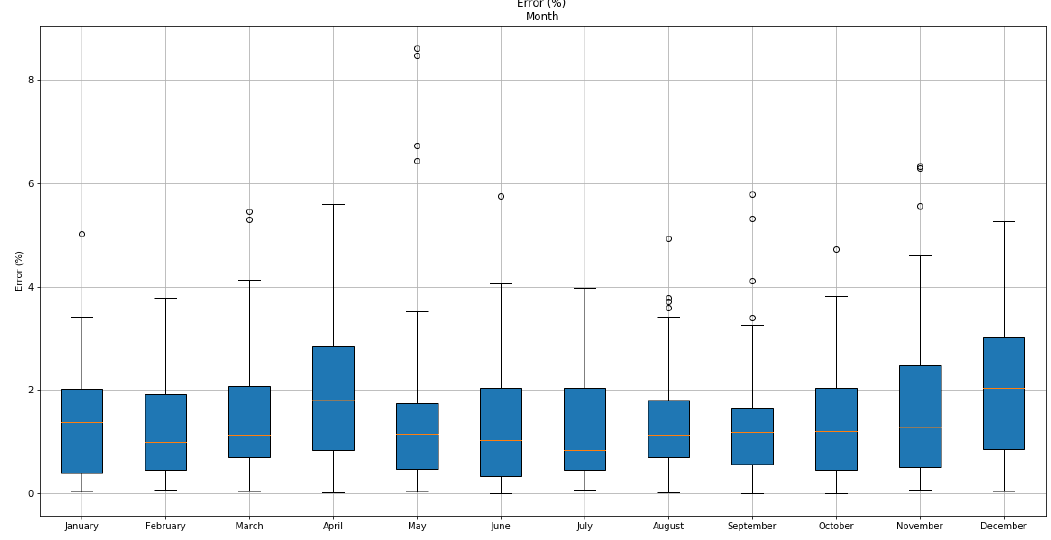
Figure 9. Absolute percentage error-specific monthly metrics over an entire year as provided by the proposed deep neural network.